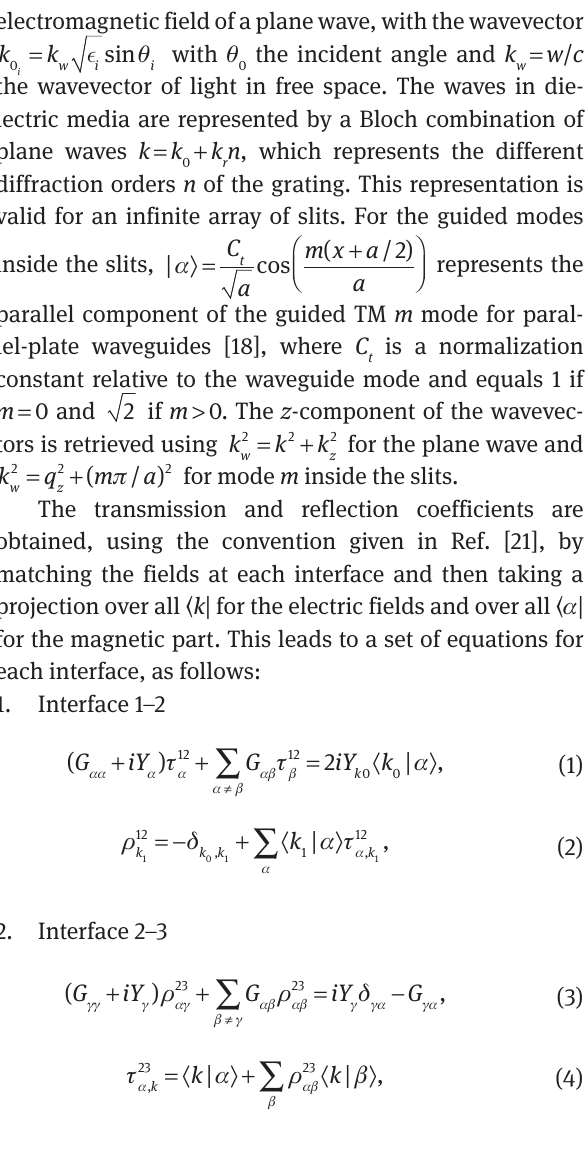
with θ the incident angle and k 0